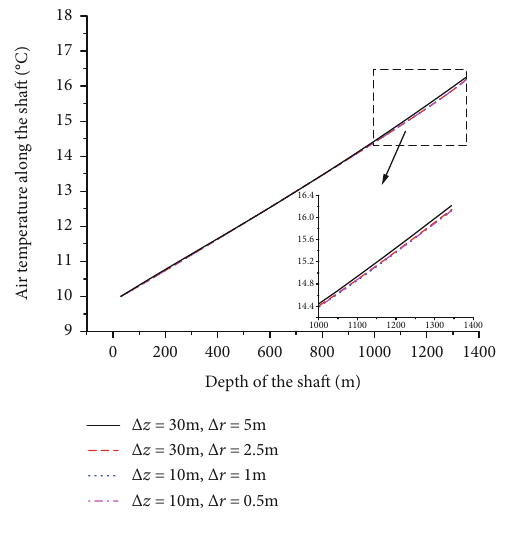
Figure 3: Grid independence veri fi cation.